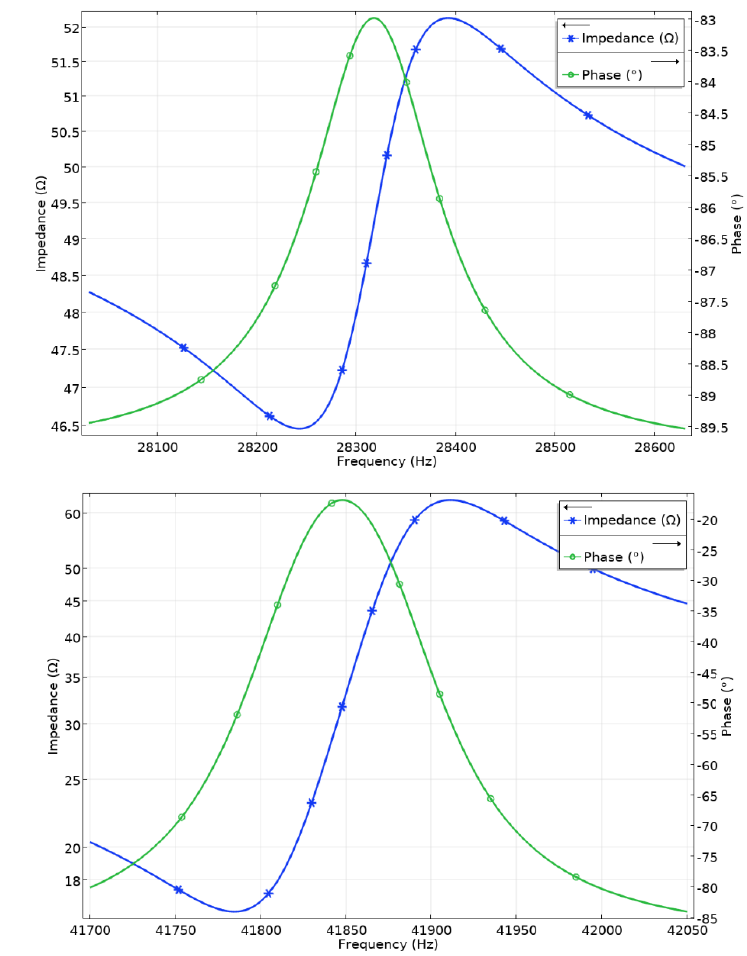
Figure 5. Impedance and phase frequency characteristics of the robot: ( a )—for planar motion; ( b )—for angular motion.